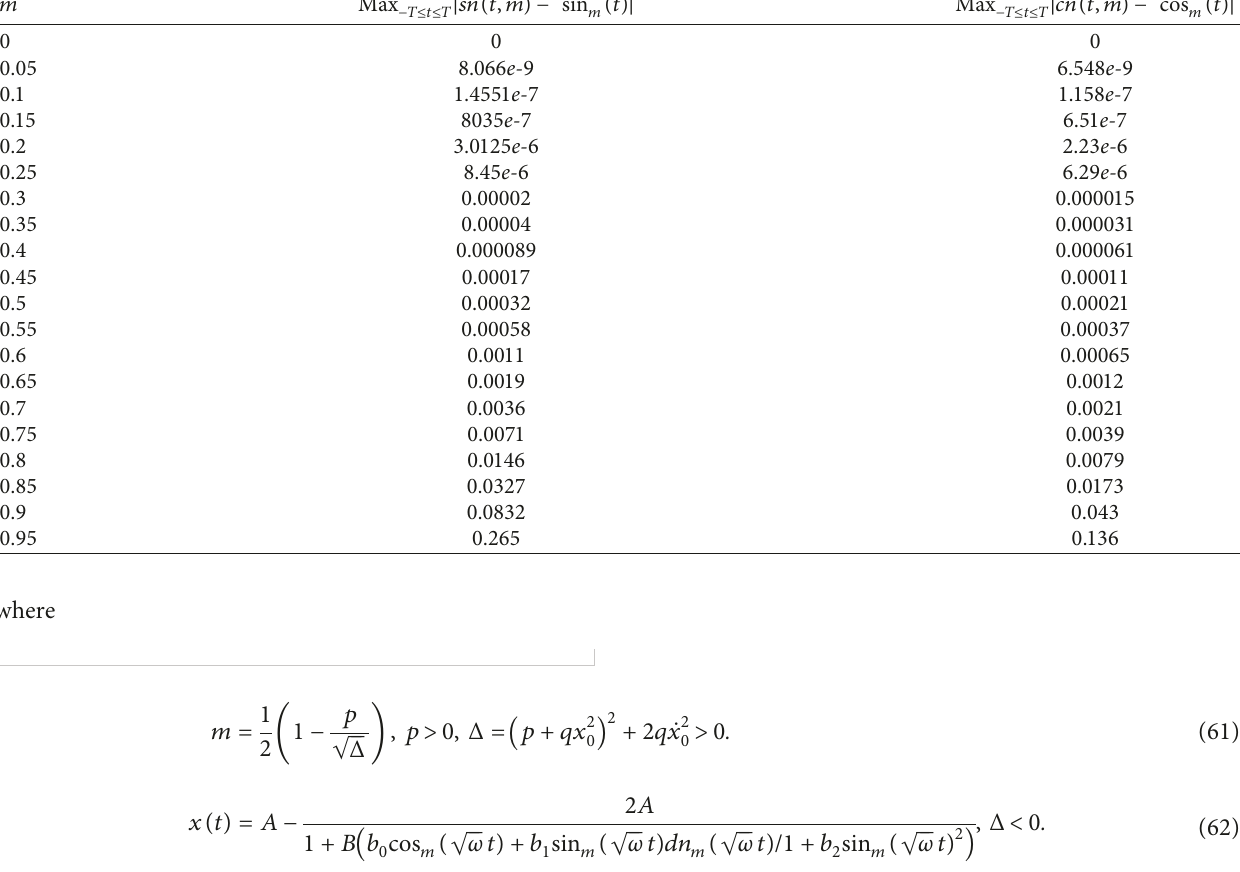
Table 2: Errors for approximations (52) and